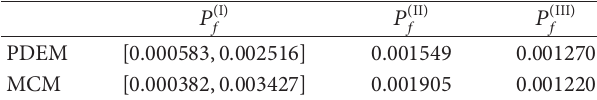
Table 3: The reliability indices of roof truss structure.